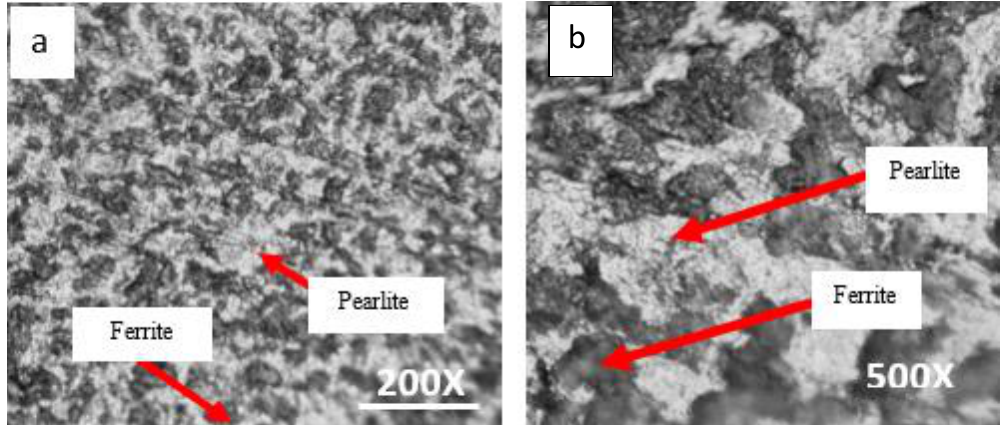
Figure 3: Optical micrograph of high carbon steel at (a) lower and (b) higher magnification for the base metal before tempering.